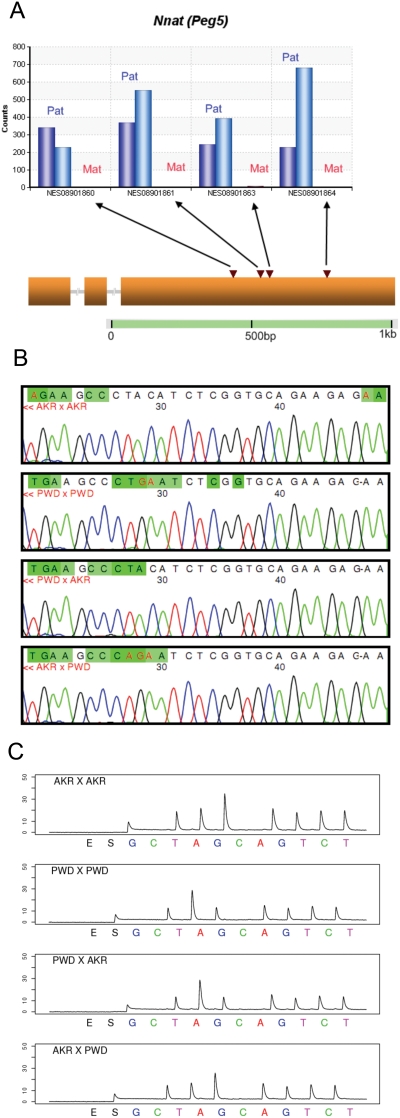
Verification for known imprinted gene Nnat (also known as Peg5).(A) Allele counts for Perlegen SNP NES08901860, NES08901861, NES08901863 and NES08901864. The blue bars (from left to right) represent the Illumina read counts from the paternal allele in PWD x AKR and AKR x PWD F1s respectively (maternal genotype listed first). The red bars represent the maternal allele Illumina read counts. (B) Sanger sequencing verification for Perlegen SNP NES08901861. We discovered an adjacent SNP position before NES08901861. The target sequence is GCCCT(AC/GA)ATCT. (C), Pyrosequencing verification for Perlegen SNP NES08901861. The target sequence is GCCCT(AC/GA)ATCT.